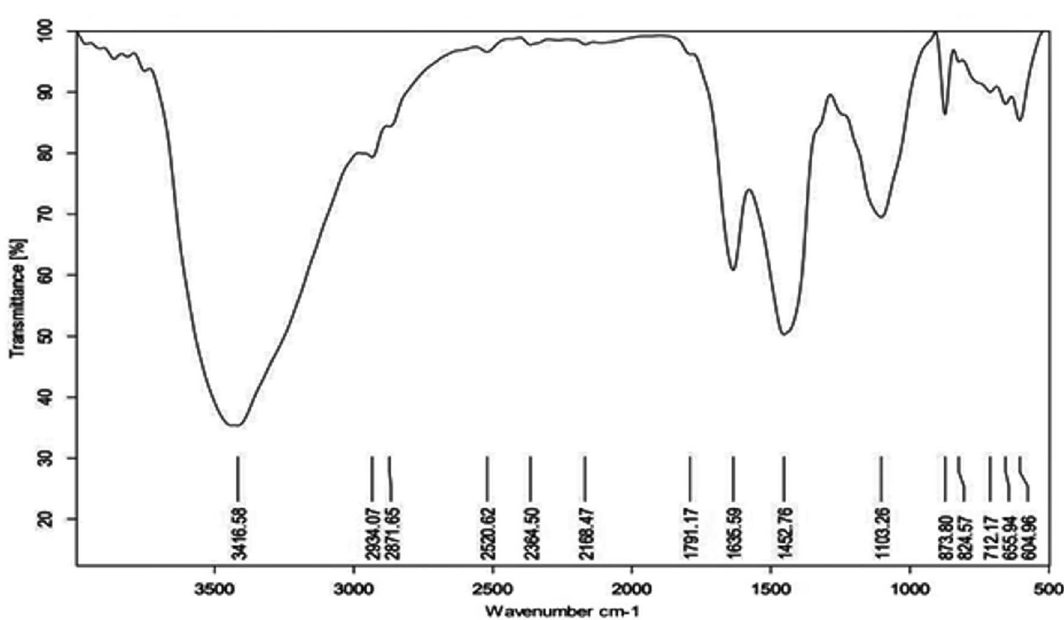
Figure 8. FT-IR spectrum of exopolysaccharide isolated from the Diatom Nitzschia